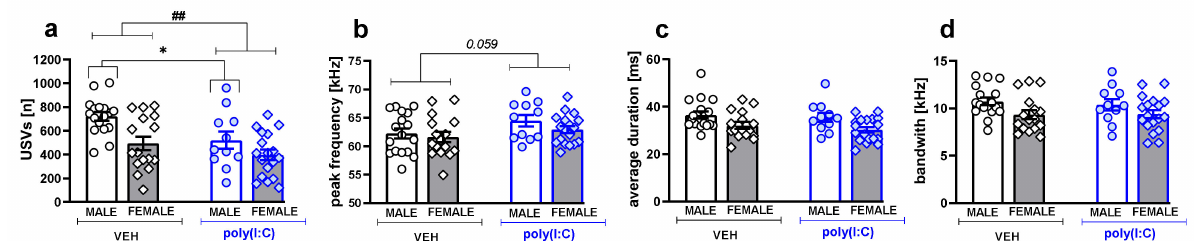
Figure 2. Poly (I:C) exposure decreased the number of USVs and changed their acoustic characteristics. Data are presented as a mean ± SEM of the total number ( a ), peak frequency ( b ), average duration ( c ), and bandwidth ( d ) of the calls. Symbols: ## p < 0.01, an overall difference between vehicle- and poly(I:C)-exposed animals (Tukey HSD post hoc test following a significant treatment effect), * p < 0.05, a significant difference between vehicle- and poly(I:C)-exposed animals in a given sex group (Student’s t